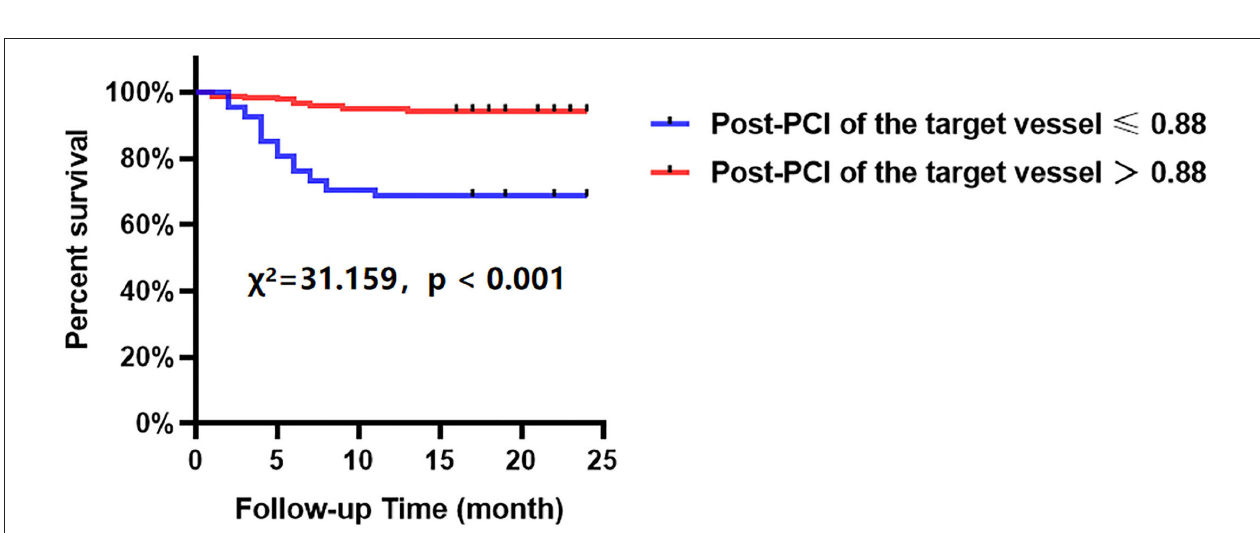
FIGURE 5 | Cumulative event-free survival probability of MACCEs in patients with NSTE-ACS who underwent PCI according to post-PCI of the target vessel.